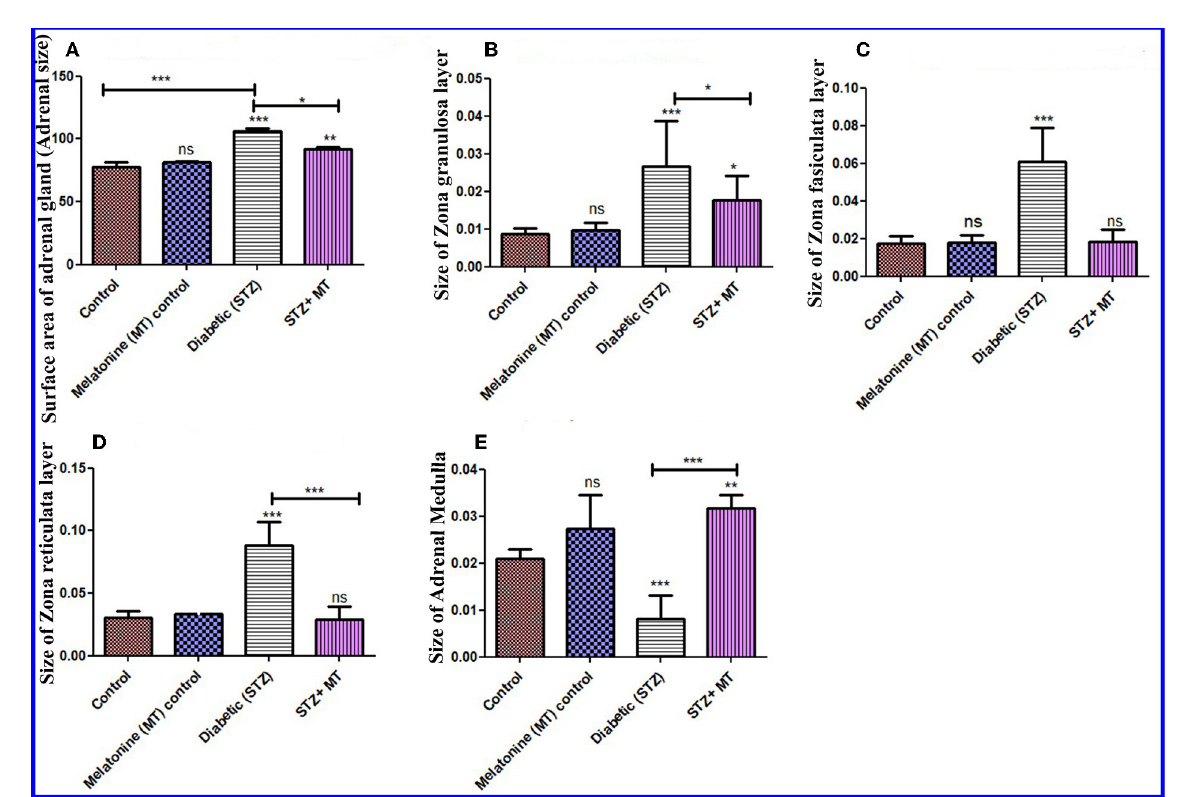
FIGURE7 Histomorphometry graph showing quantitative measurements of adrenal tissue sections among the experimental groups. (A) Surface area of adrenal glands (size), (B) Size of the ZG layer, (C) size of the ZF layer, (D) size of the ZR layer, and (E) size of the adrenal medulla. Data are expressed as means ± standard deviations. Significant differences vs. the control group are marked by different asterisks through one-way ANOVA with Tukey’s post hoc test: * P ≤ 0.05, ** P ≤ 0.01, *** P ≤